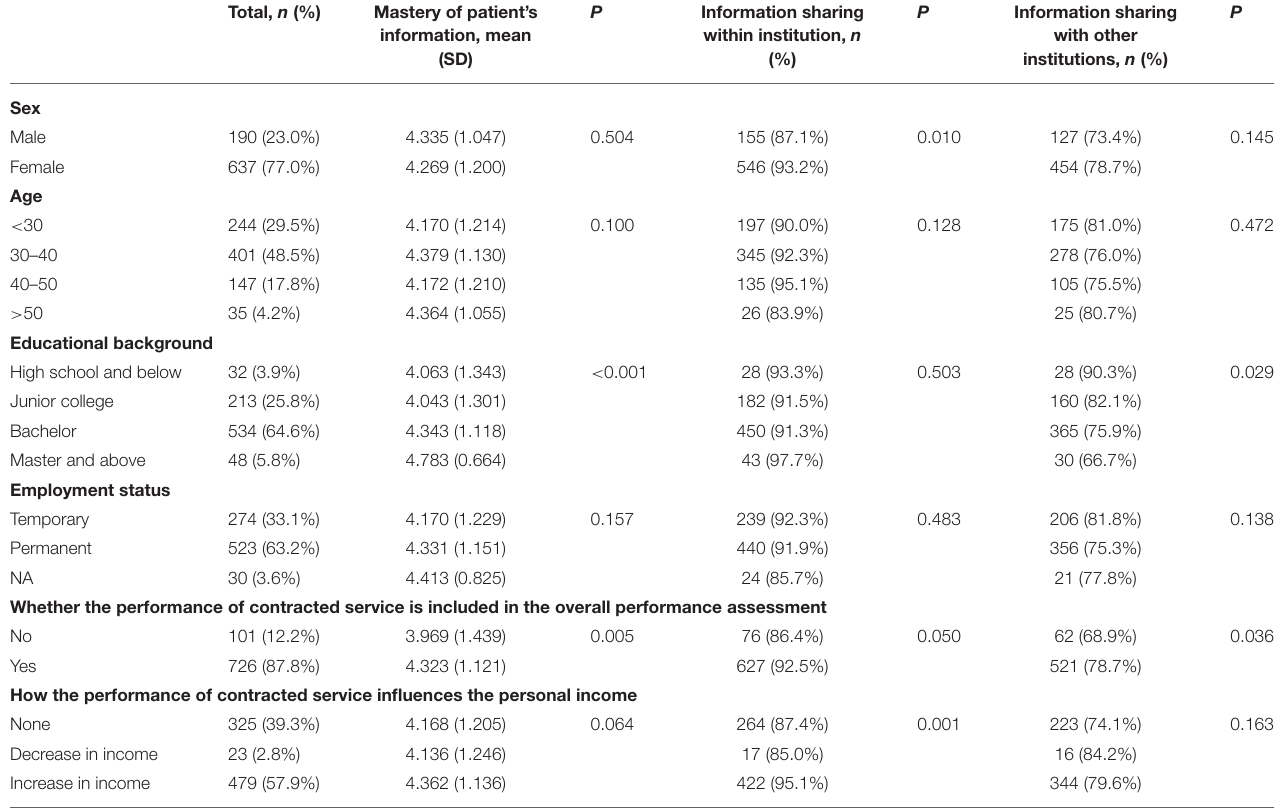
TABLE 1 | Characteristics of primary healthcare providers.